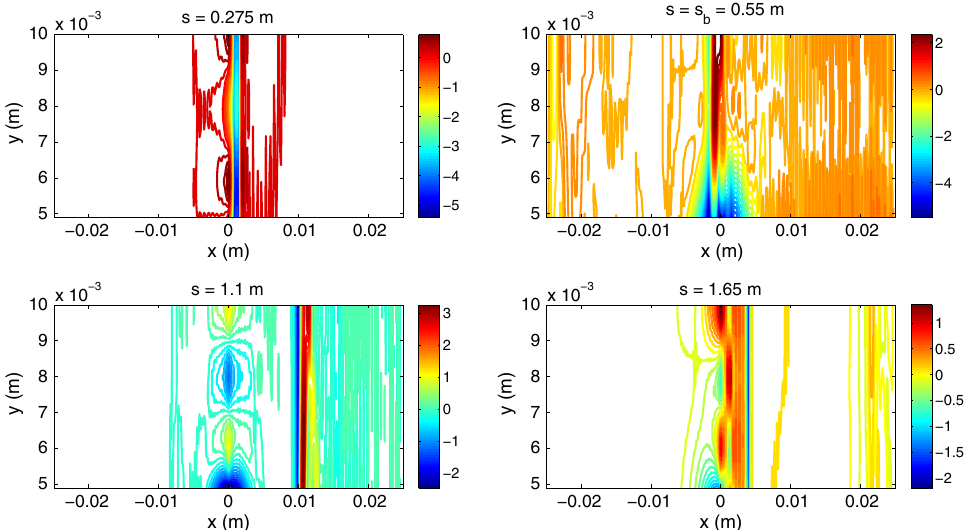
s; x; y; t Þ in the ð x; y Þ -plane at the instant the bunch is at location s . Plots in the upper 1 = 4 of the chamber FIG. 16. Contour plots of H x ð only, in arbitrary units.